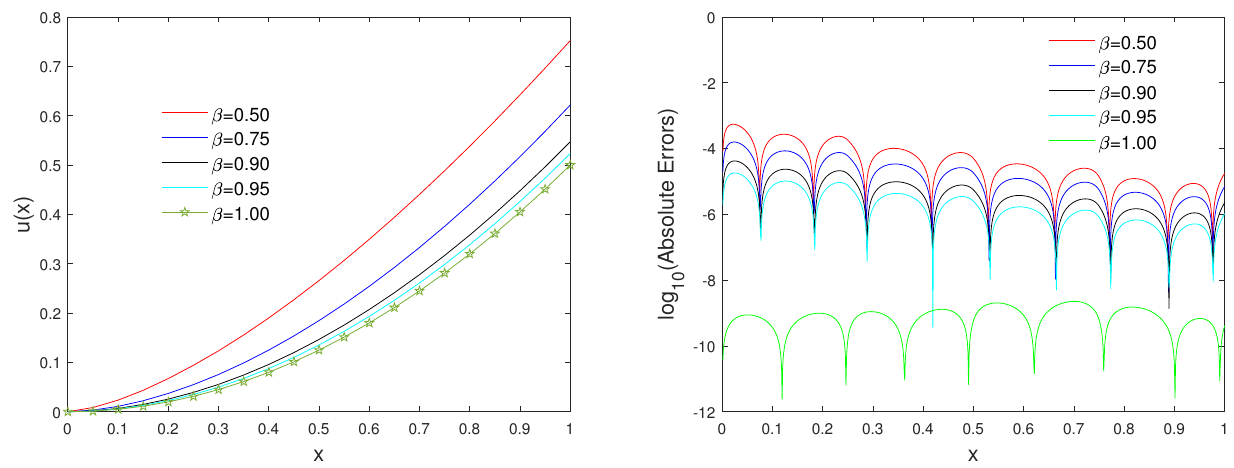
Figure 2. Comparing the approximate and exact solutions, taking s = 2 and different values of β , for Example 1.